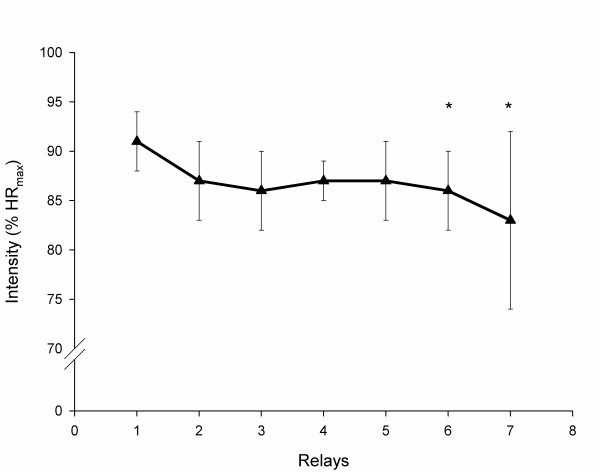
Evolution of the intensity, expressed as % of maximum heart rate (HRmax), during the event. * Statistical difference (P < 0.05) mean intensity between the first relay compared with the sixth and seventh relay.